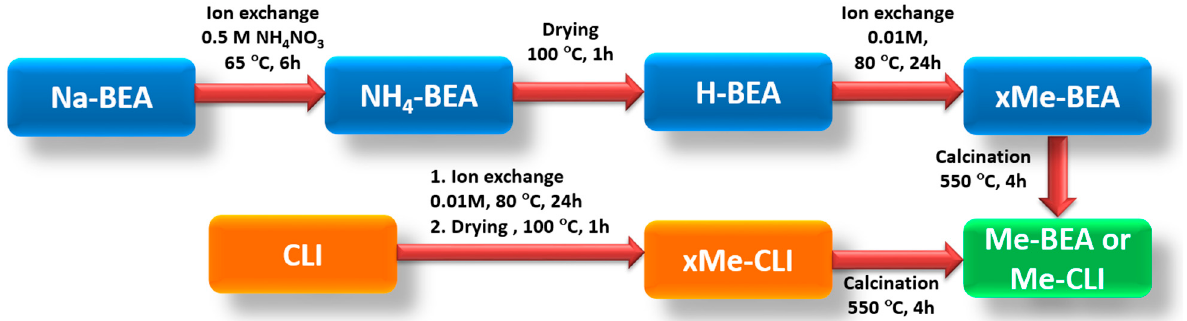
Figure 11. Scheme for obtaining zeolite catalysts based on BEA and CLI; Me (metals: Sn, Fe, Cu, Zn), and xMe (salt solution concentration—0.01 M).